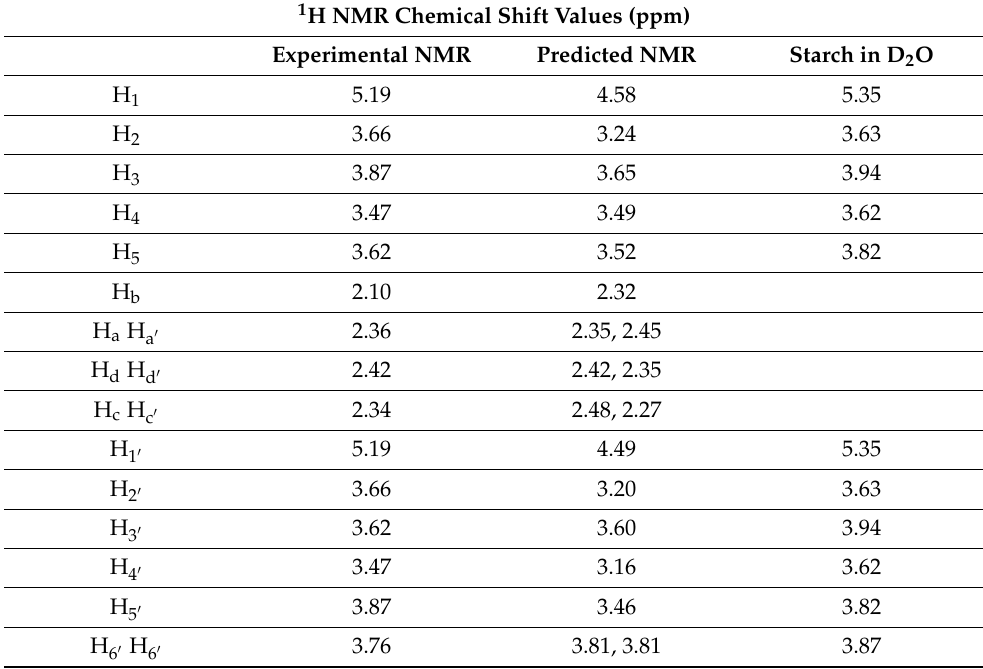
Table 1. Proton chemical shift assignments for the experimental 1 H NMR data, predicted 1 H NMR data (nmrdb.org), and starch dissolved in D 2 O as a reference [26]. 1 H NMR Chemical Shift Values